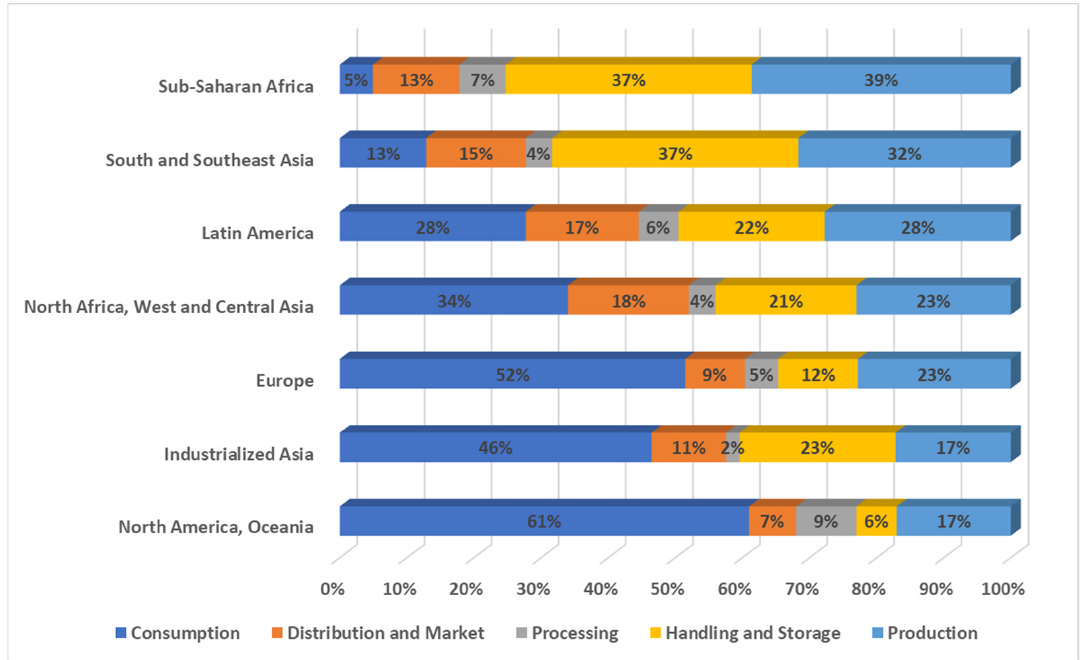
Figure 2. Food loss or waste in developing and developed nations [23].